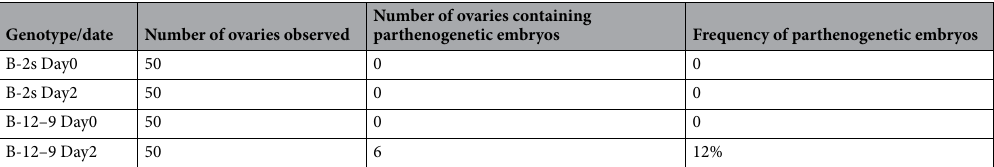
Table 1. Parthenogenetic embryo frequency in sexual and apomictic ovaries on Day0 and